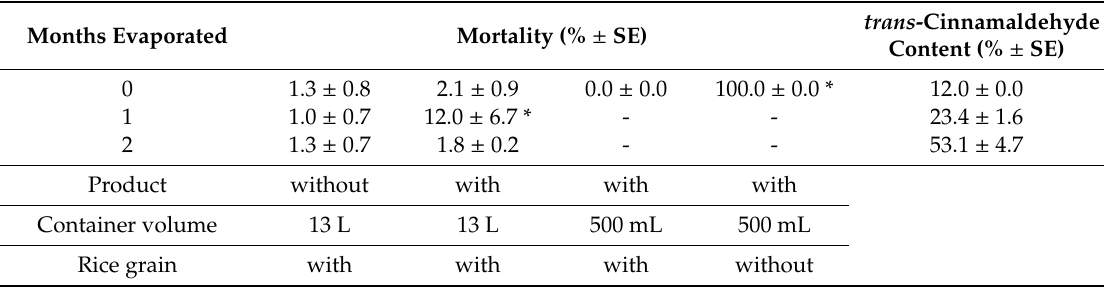
Container volume Rice grain with with with without with with with without * Asterisks denote significant differences at p = 0.05. * Asterisks denote significant di ff erences at p =